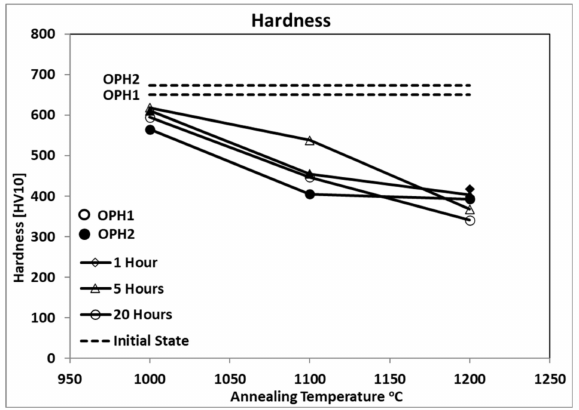
Figure 2. Hardness (HV10) at di ff erent